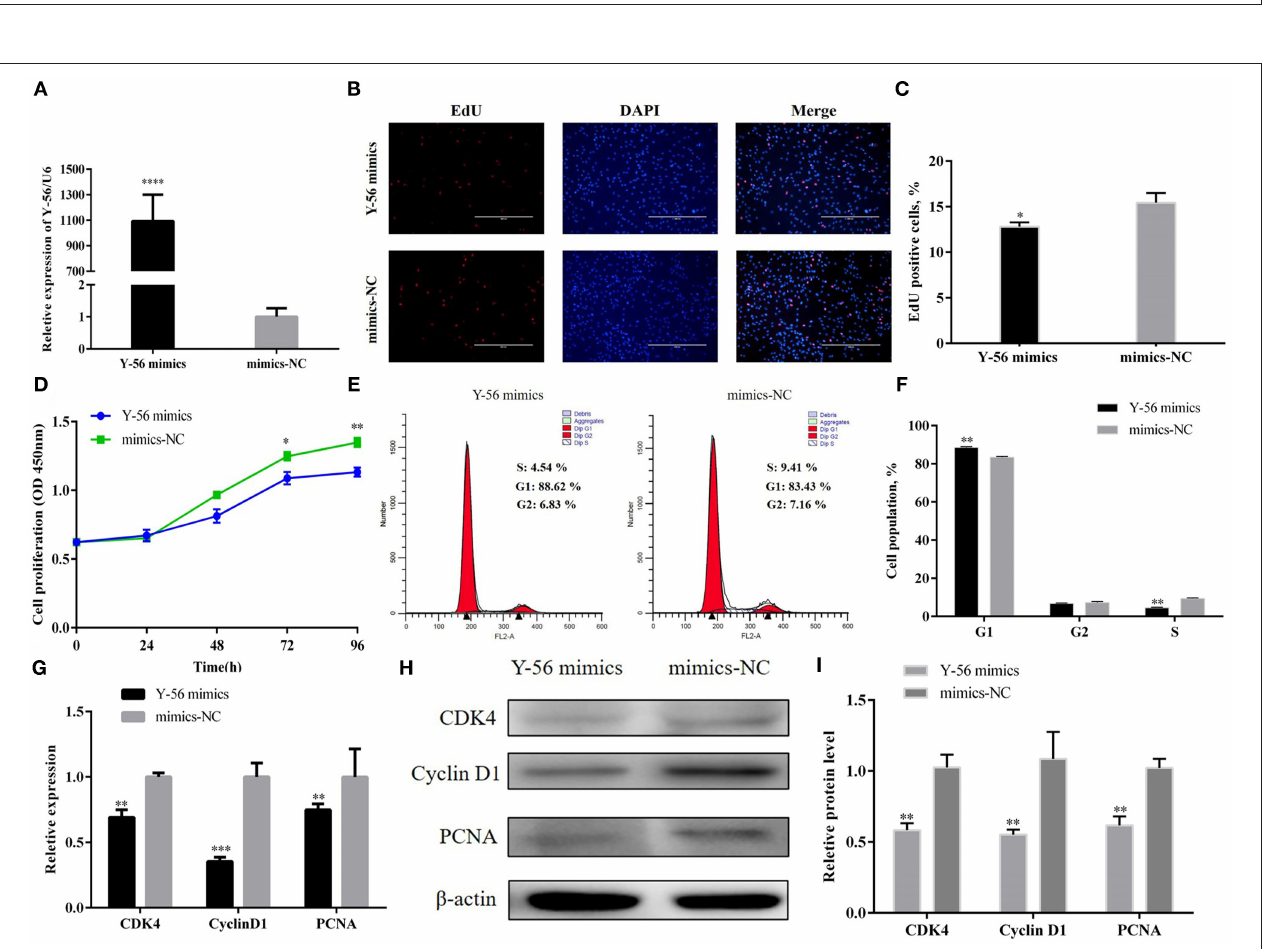
FIGURE 1 | Expression level of Y-56 on the different porcine tissues of LP and BM. (A) Volcano plot of the observed fold changes in miRNA expression vs. significance. (B) qRT-PCR analysis of Y-56 expression in different porcine tissues. (C) MRNA expression level of Y-56 in BM and LP (* P < 0.05, ** P < 0.01, and *** P < 0.001).